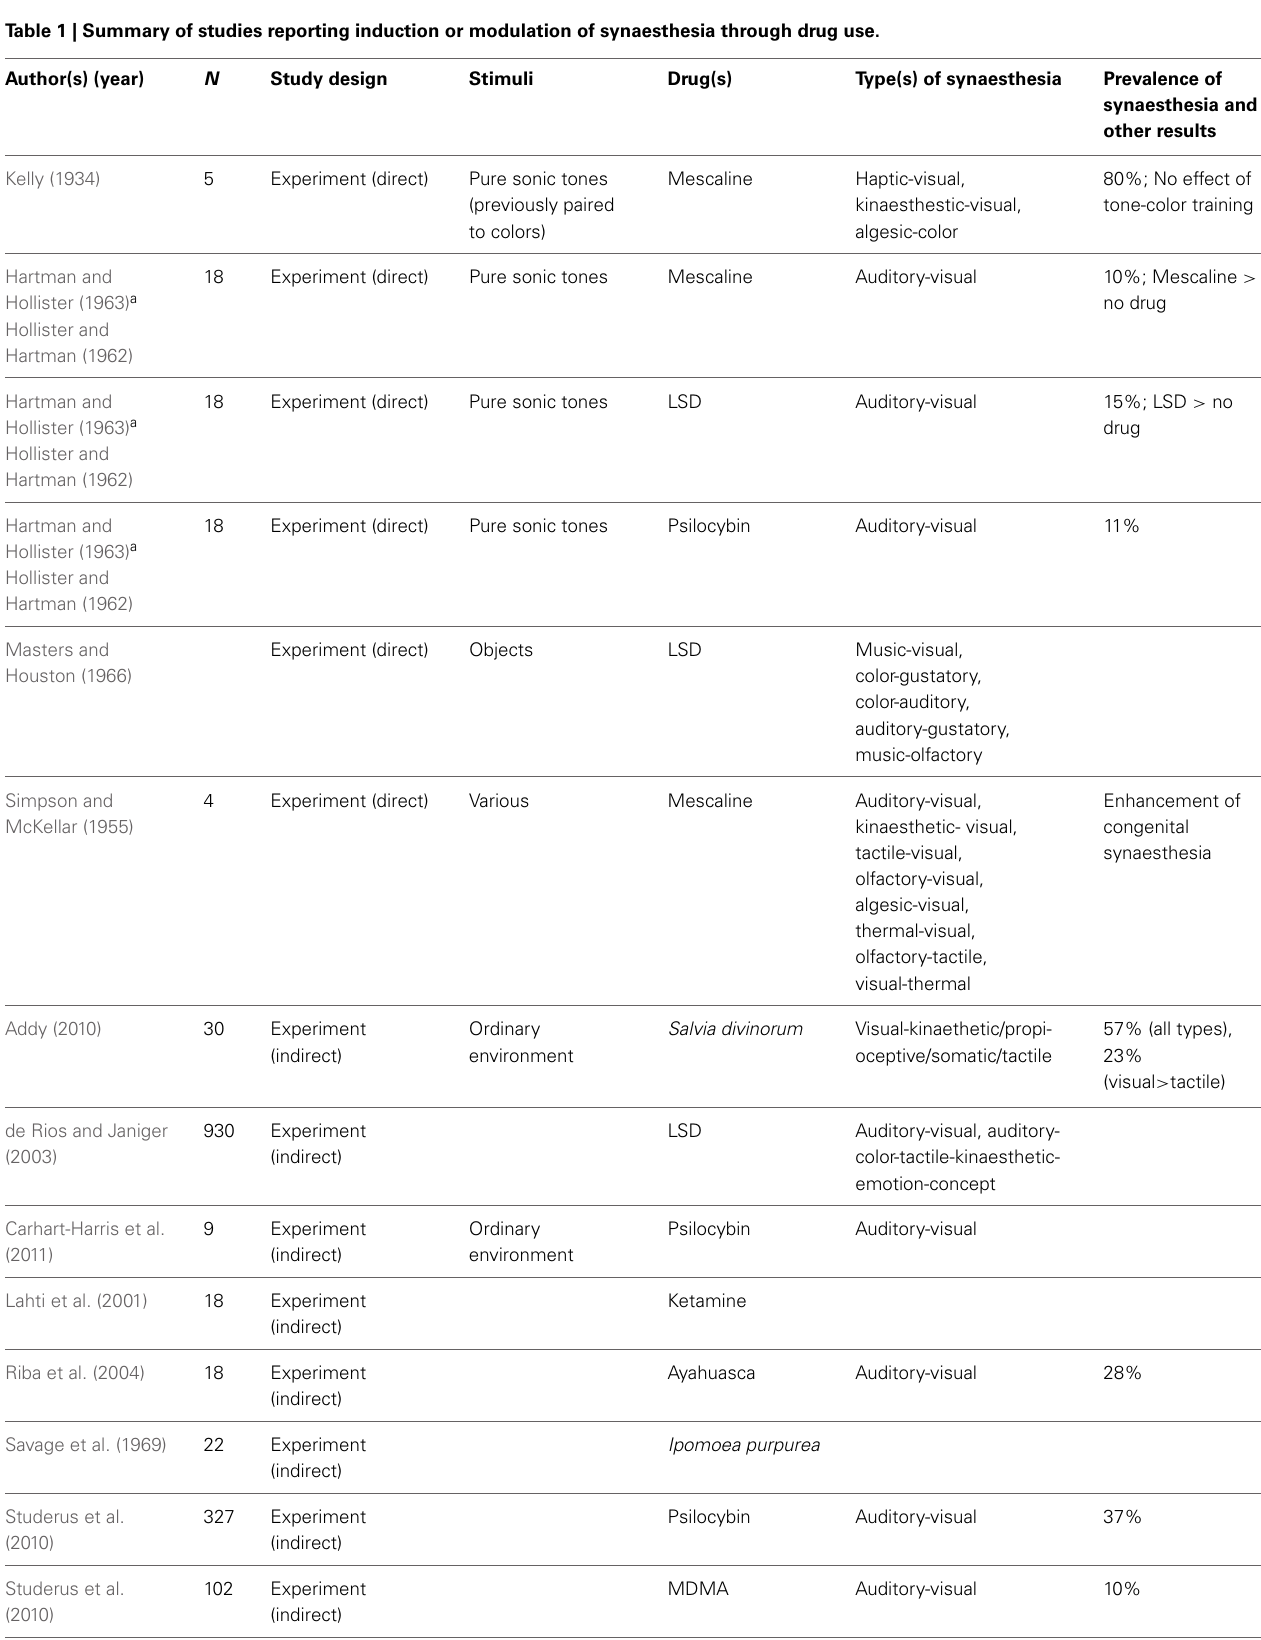
Table 1 | Summary of studies reporting induction or modulation of synaesthesia through drug